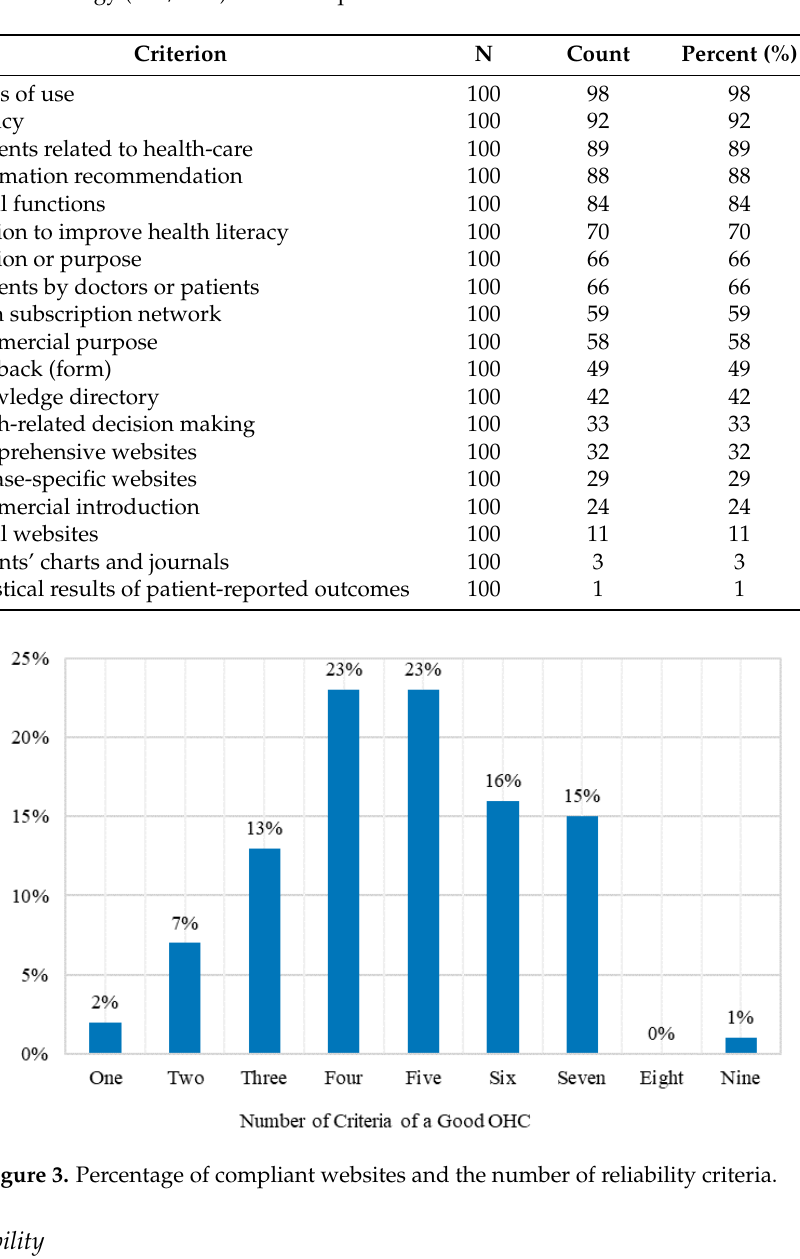
Figure 4. Percentage of websites in terms of convenience in user interaction. Table 4. Estimated percentages of websites in compliance with the criterion of site design. Criterion